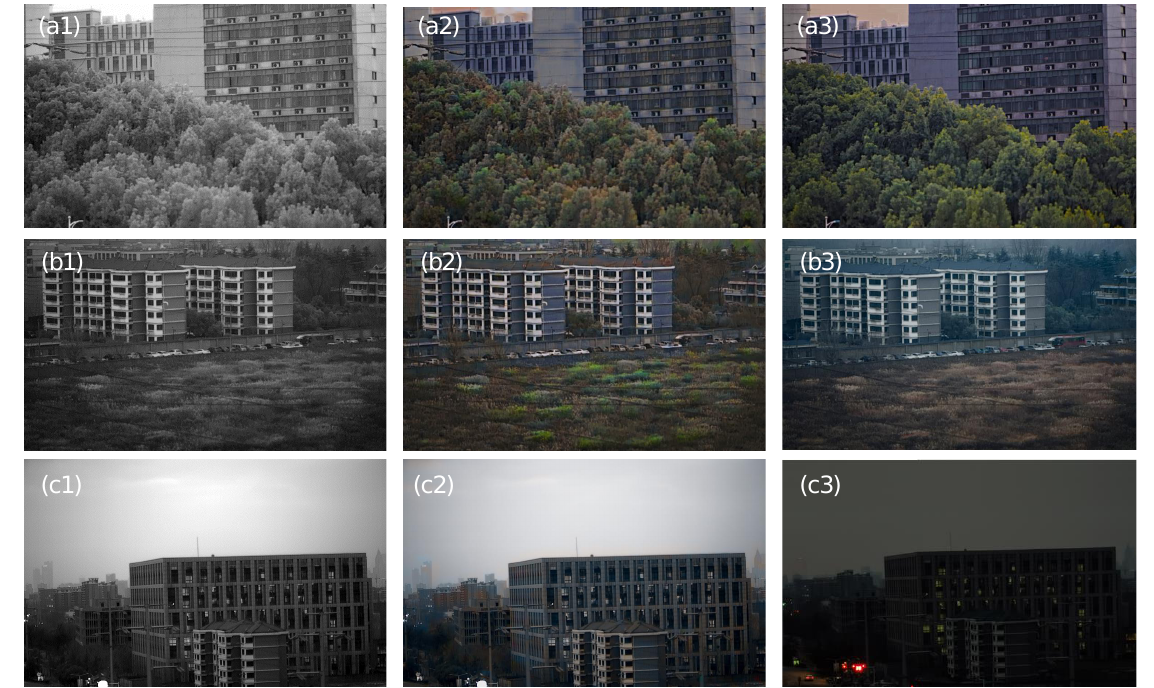
Figure 10. The image color reconstruction results based on the scene. ( a1 – c1 ) Input grayscale images; ( a2 – c2 ) output color images; and ( a3 – c3 ) color images captured by the visible sensor.